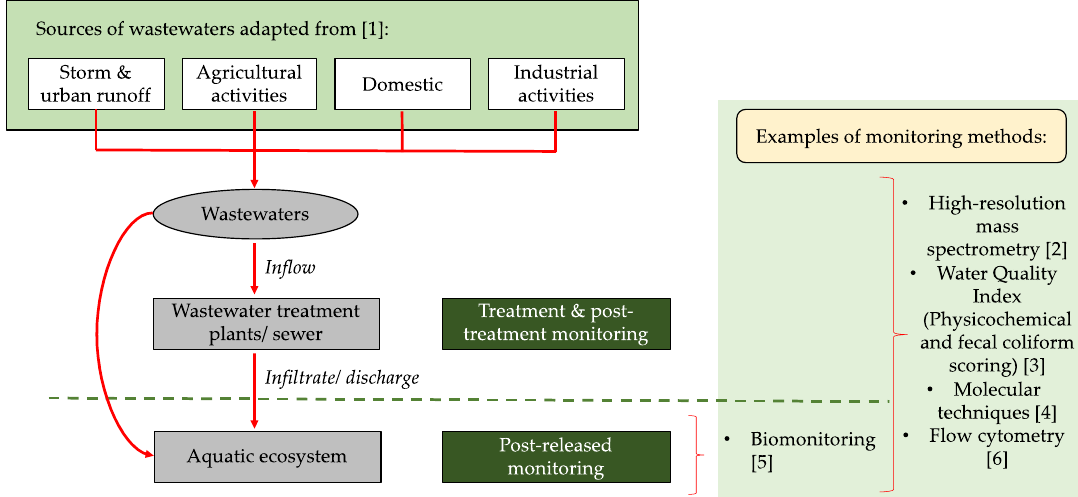
Figure 1. Monitoring approaches for aquatic pollution caused by anthropogenic wastewaters [1–6].